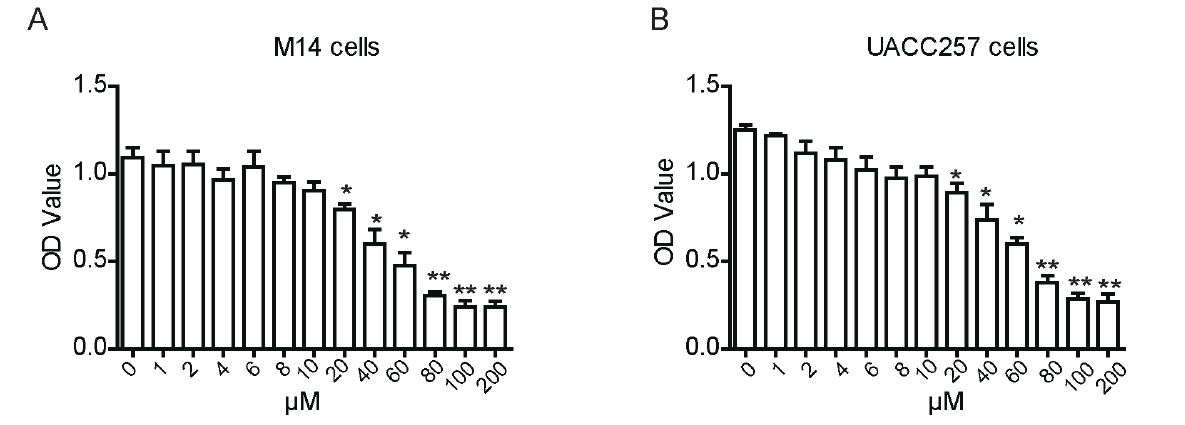
Figure 1: MDA-19 inhibits melanoma cells in a dose-dependent manner. (A) (B) M14 cell (A) and UACC257 cell (B) were treated with different concentrations of MDA-19 for 24h, the absorbance was detected using CCK8 kit. Data are expressed as the mean ± SD. *P<0.05,